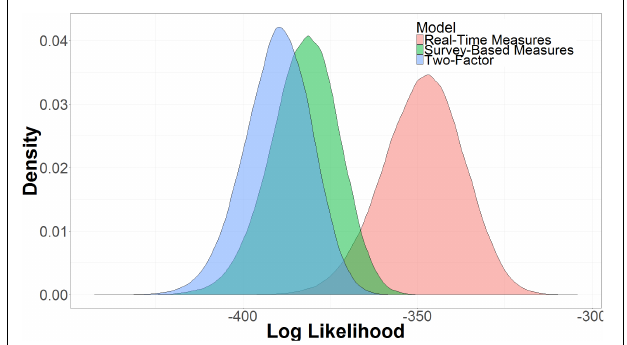
FIGURE 7 | Interaction of AUC, authentication level, and spoof/non-spoof on identifying spoof or non-spoof site. The data on the x-axis are normalized and range from 2 SD below the mean ( − 1.00) to 2 SD above the mean ( + 1.00).